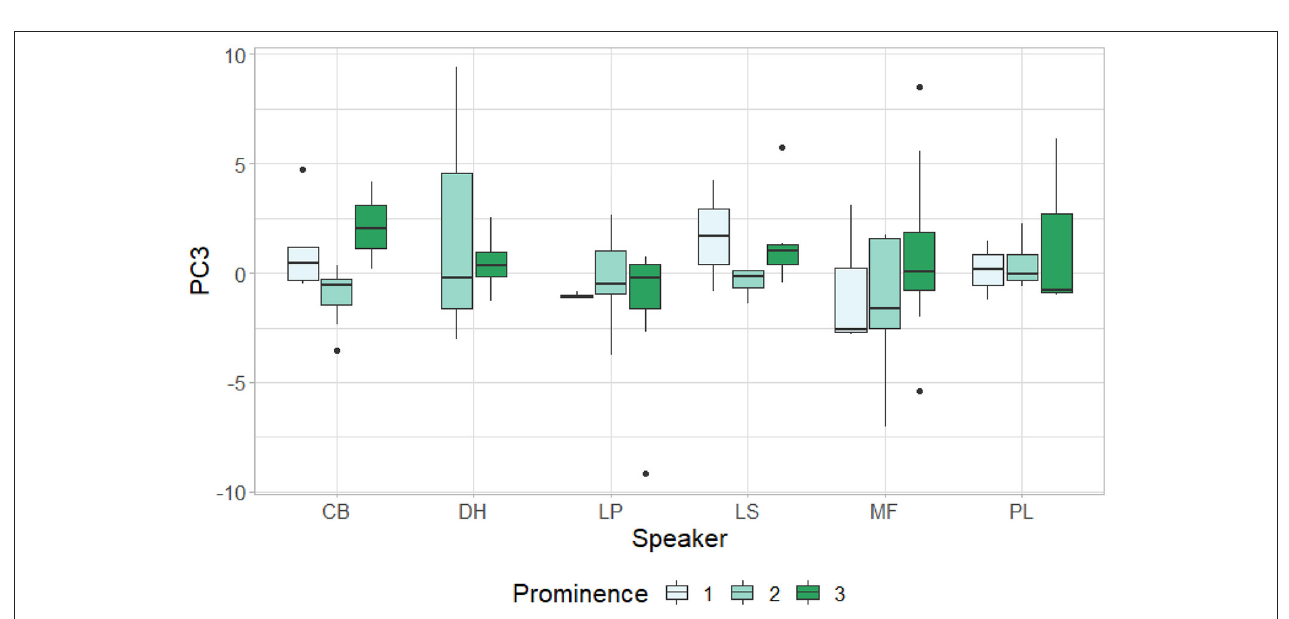
FIGURE 8 | The first three PCs resulting from the FPCA analysis of F0 with AU01. The top row (y1) shows the variability in F0, and the bottom row (y2) shows the variability in eyebrow movements. The black line shows the mean of all contours, while the red lines show contours with a high positive value for the given PC, and the blue lines show contours with a low negative value for the given PC. Note that the red and blue lines do not show density of the distributions of the PCs, and thus in some cases give non-real values (e.g.,values below 0 or above 5 for y2, the eyebrow measurements.).